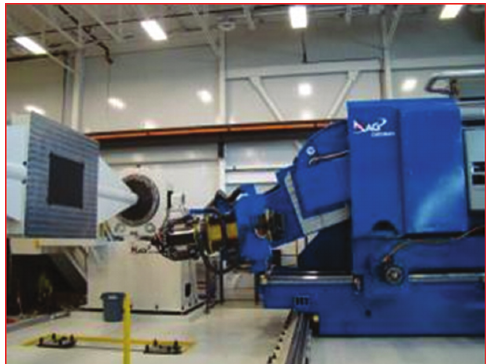
Figure 6 Viper 4000 fiber placement machine.